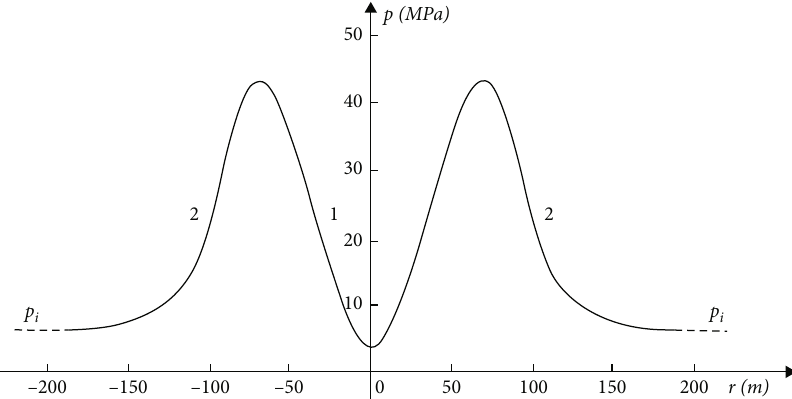
Figure 7: Pressure distribution perpendicular to fracture direction during single fracture fracturing fl uid fl owback.